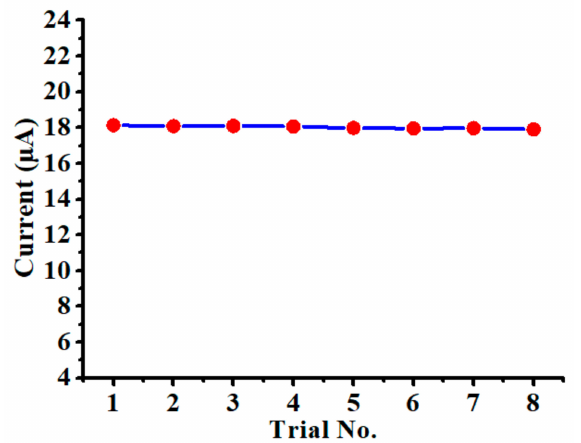
Figure 8. Stripping peak currents measured by the nanoparticles-modified chemical sensor in the solution of 5 µ g/L Cd(II) with 0.1 M acetate buffer, where deposition potential is − 1.0 V and deposition time is 120